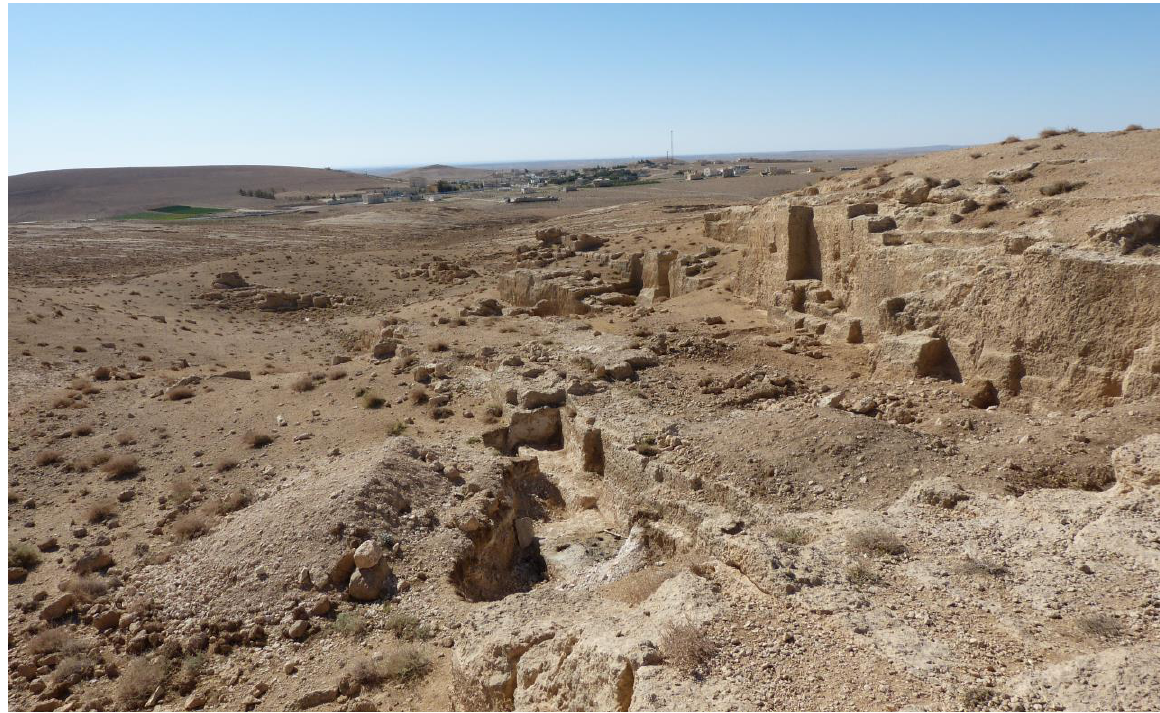
Figure 2. Part of the large Roman quarries northwest of Udhruh. Photograph by A.